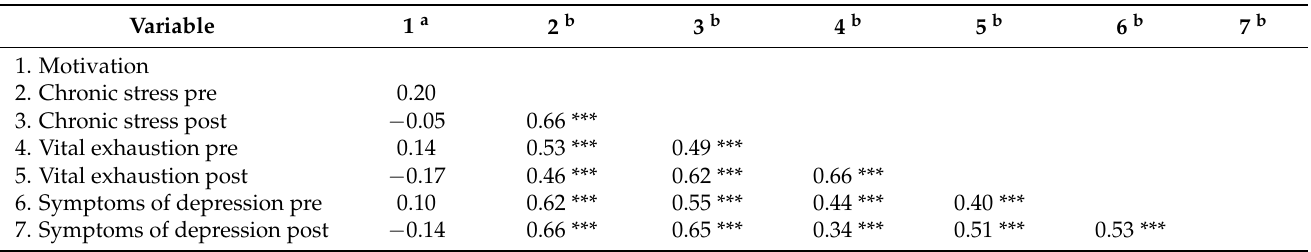
Table 3. Correlations among study variables.